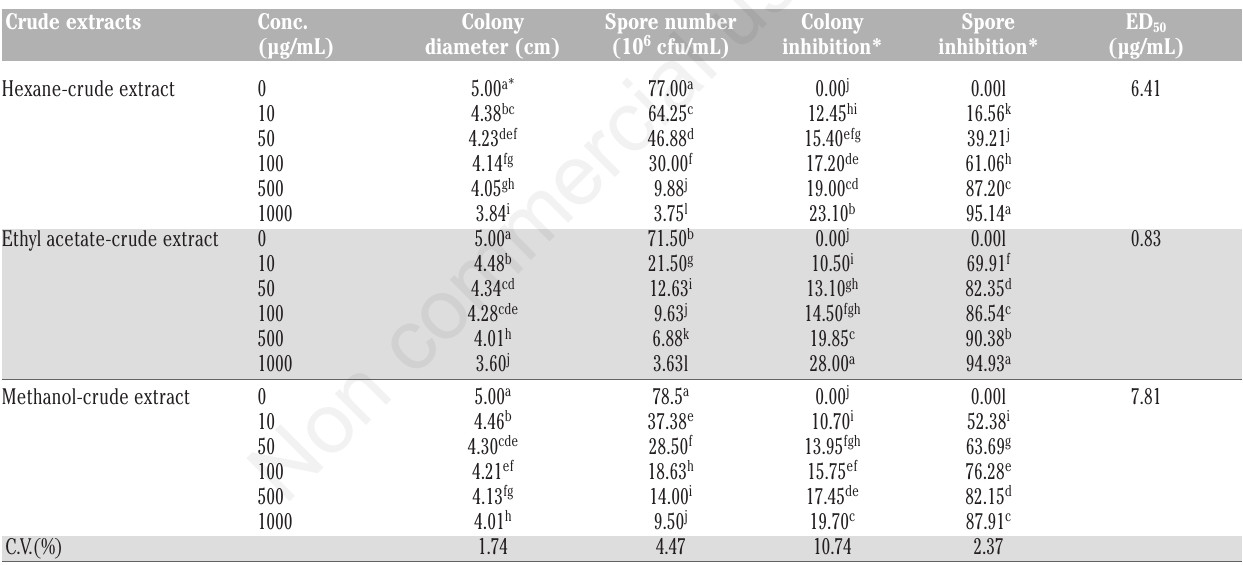
Table 1. Antifungal metabolites from Chaetomium cupreum CC3003 against Curvularia lunata. Crude extracts Conc.